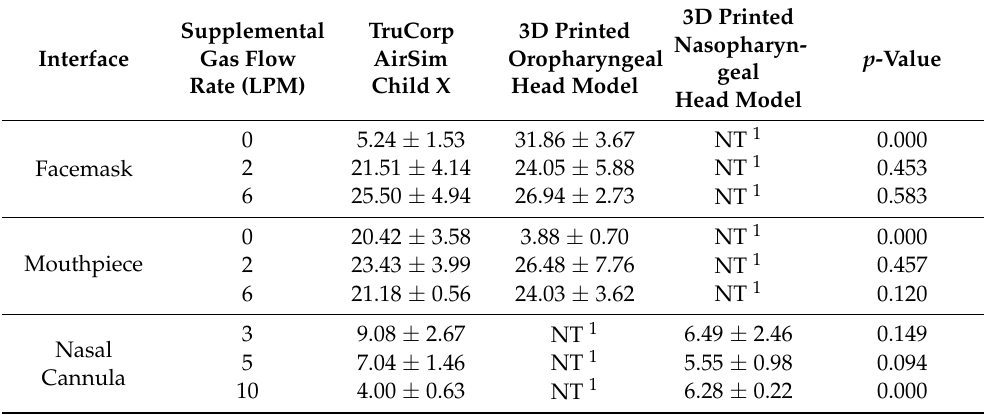
Table 3. Mean ± SD % tracheal dose for Paediatric Head Models in combination with the Aerogen Ultra with a facemask or mouthpiece and the Aerogen Solo/Airvo 2 with Optiflow Nasal cannula at supplemental flow rates of 0, 2 and 6 LPM and high flow gas rates of 3, 5 and 10 LPM respectively.